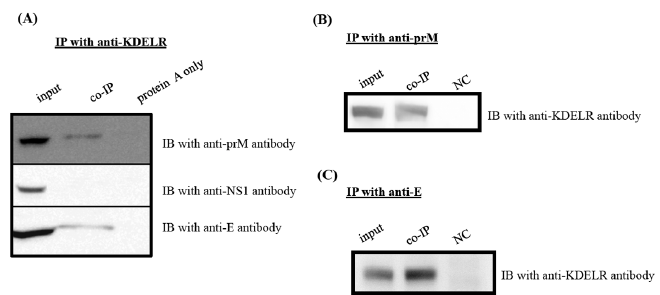
Figure 6. KDELR protein binds to JE viral structural proteins, but not NS1 protein. Cell lysates of BHK-21 cells with mock-infected or JEV-infected for 48 h were immunoprecipitated (IP) with anti-KDELR antibody ( A ), anti-prM antibody ( B ) and anti-E antibody ( C ), respectively. The membranes were then analyzed with various specific antibodies as indicated. ( A ) The IP membranes were immunoblotting with anti-prM-, anti-NS1- and anti-E-specific antibodies, respectively; ( B,C ) the IP membrane was immunoblotted with anti-KDELR antibody. Please note that cell lysates alone are shown on the left side as input reference. IB, immunoblot; IP, immunoprecipitation.